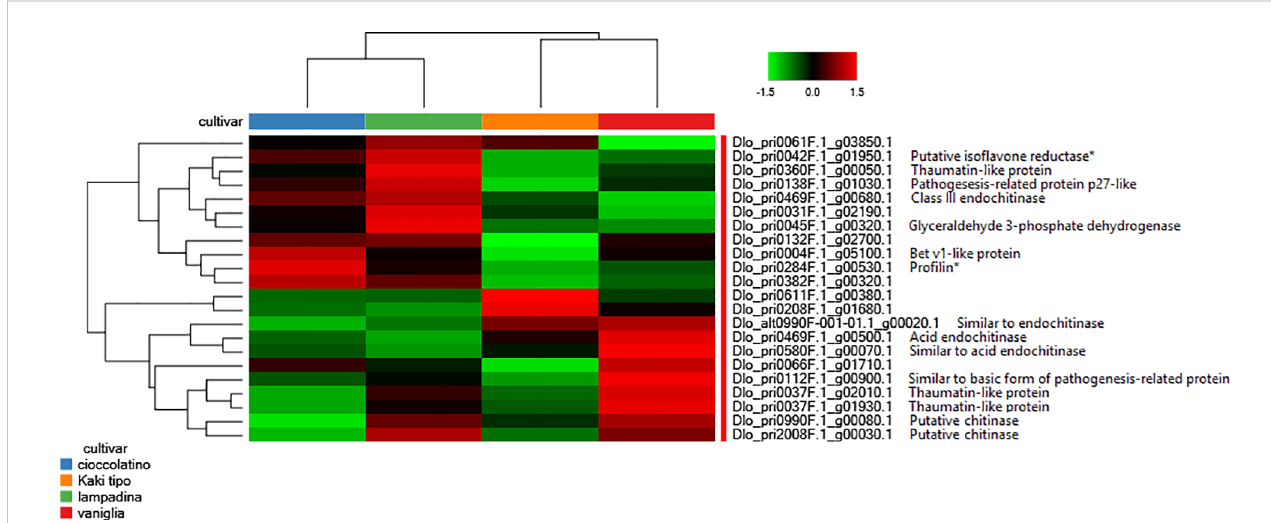
FIGURE 4 Heat-map reporting the variable abundance of differentially represented proteins involved in response to external stimuli and allergenicity in persimmon fruits of Kaki tipo, Cioccolatino, Vaniglia and Lampadina cultivars. Each column corresponds to a cultivar, whereas each row represents a single protein. Increasing brightness towards red indicates higher protein responses (measured as summed peak areas) and green indicates lower protein responses. Protein abundance values were grouped for three replicates and scaled before clustering. Known allergenic components present in persimmon and other fruits (https://www.allergome.org/) included iso fl avone reductase (dlo_pri0042f.1_g01950.1), some thaumatin-like proteins (dlo_pri0360f.1_g00050.1, dlo_pri0037f.1_g02010.1 and dlo_pri0037f.1_g01930.1), some pathogenesis-related proteins (dlo_pri0138f.1_g01030.1 and